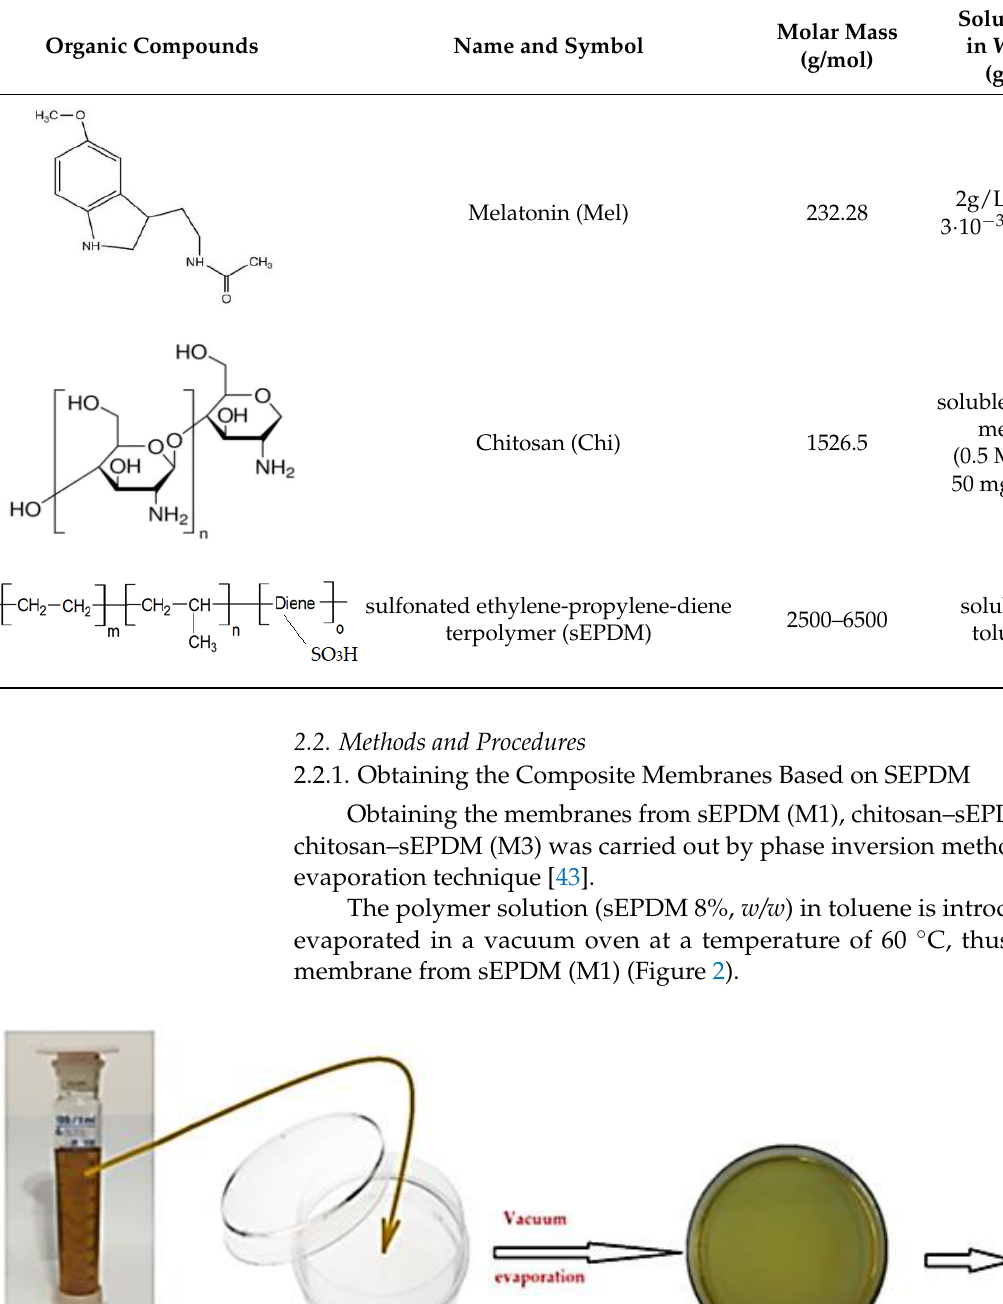
Table 1. The characteristics of the used organic compounds.